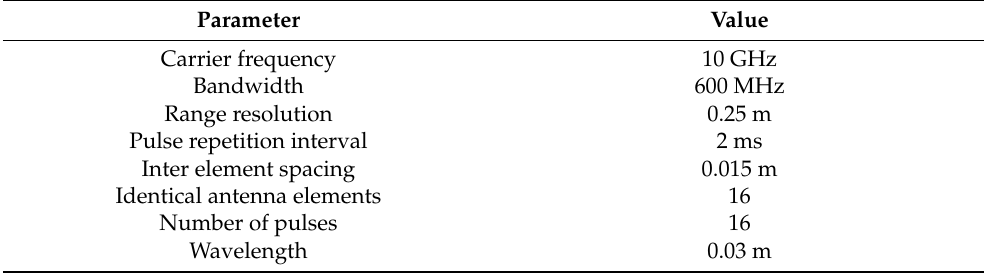
Table 1. Parameters of radar.